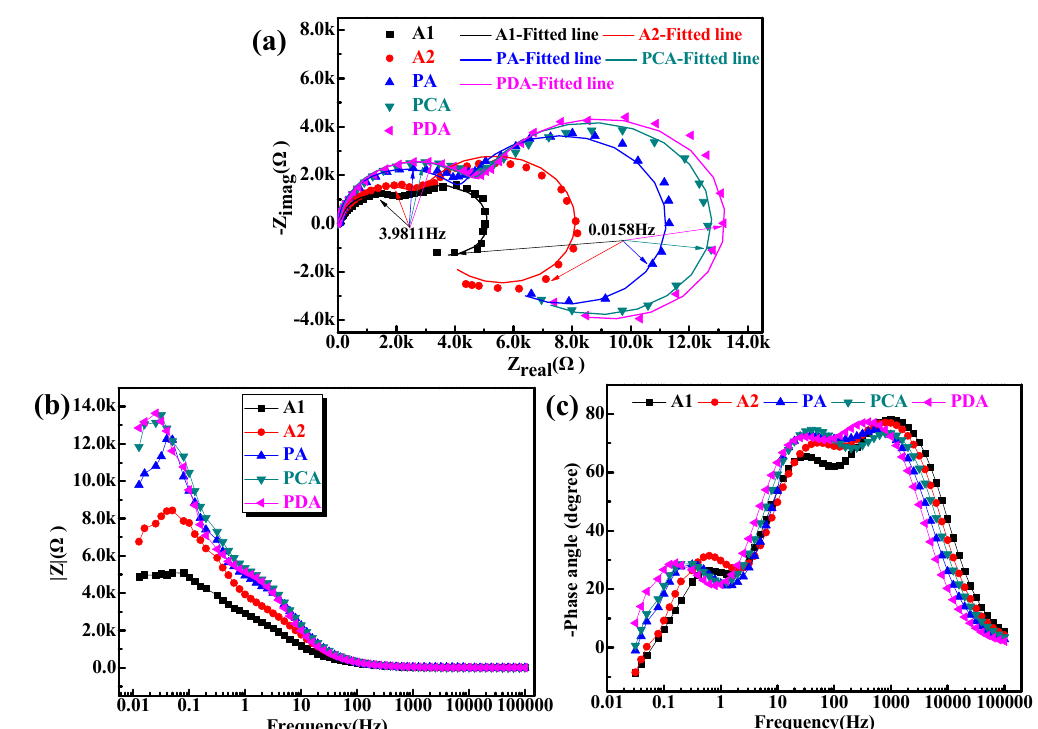
Figure 3. Nyquist plots ( a ) and corresponding Bode plots ( b , c ) of the five aged samples during immersion in 3.5 wt% NaCl solution.